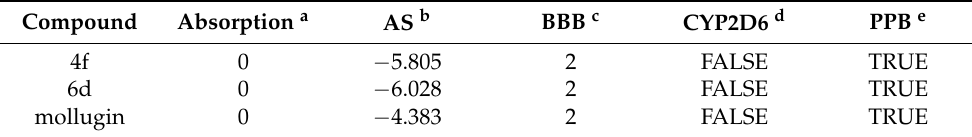
Figure 4. ADMET plot of compounds 4f and 6d. Table 7. Prediction of ADMET properties.